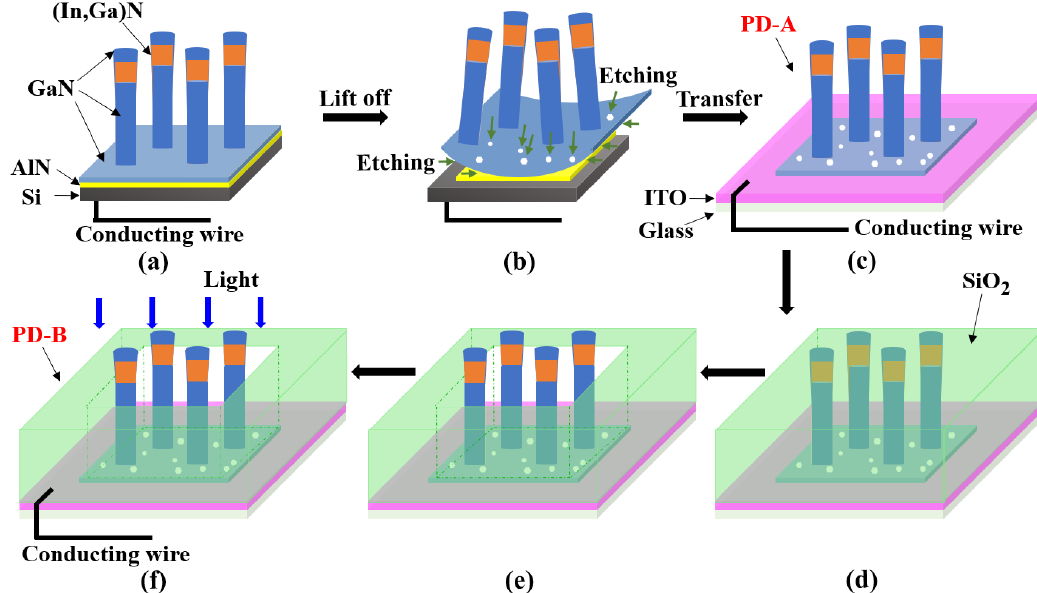
Figure 1. Schematic illustration of fabricating the PEC PD. ( a ) MBE growth of (In,Ga)N NWs on Si substrate; ( b ) use the EC etching to detach (In,Ga)N NW film from the epitaxial substrate; ( c ) transfer the NW film to an ITO/glass substrate; ( d ) deposit the SiO 2 dielectric layer; ( e ) selectively etch the SiO 2 layer to expose the NWs to air; ( f ) connect the PD with conducting wire and measure it under illumination.